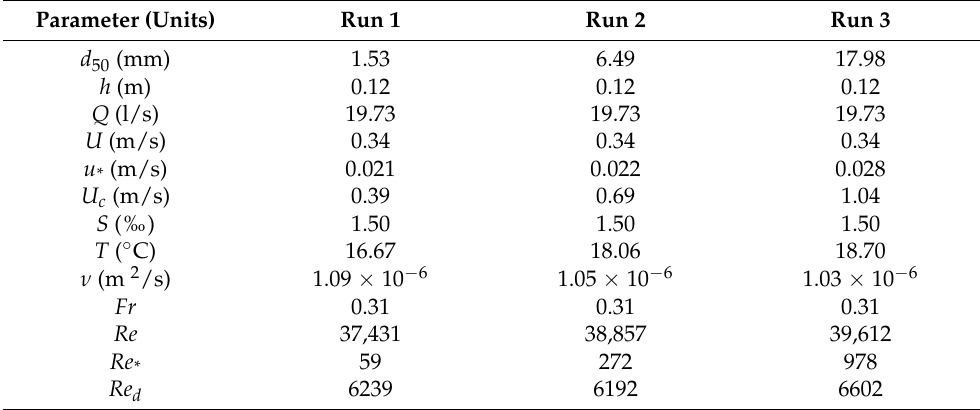
Table 1. Hydraulic conditions of the experimental study for the approaching